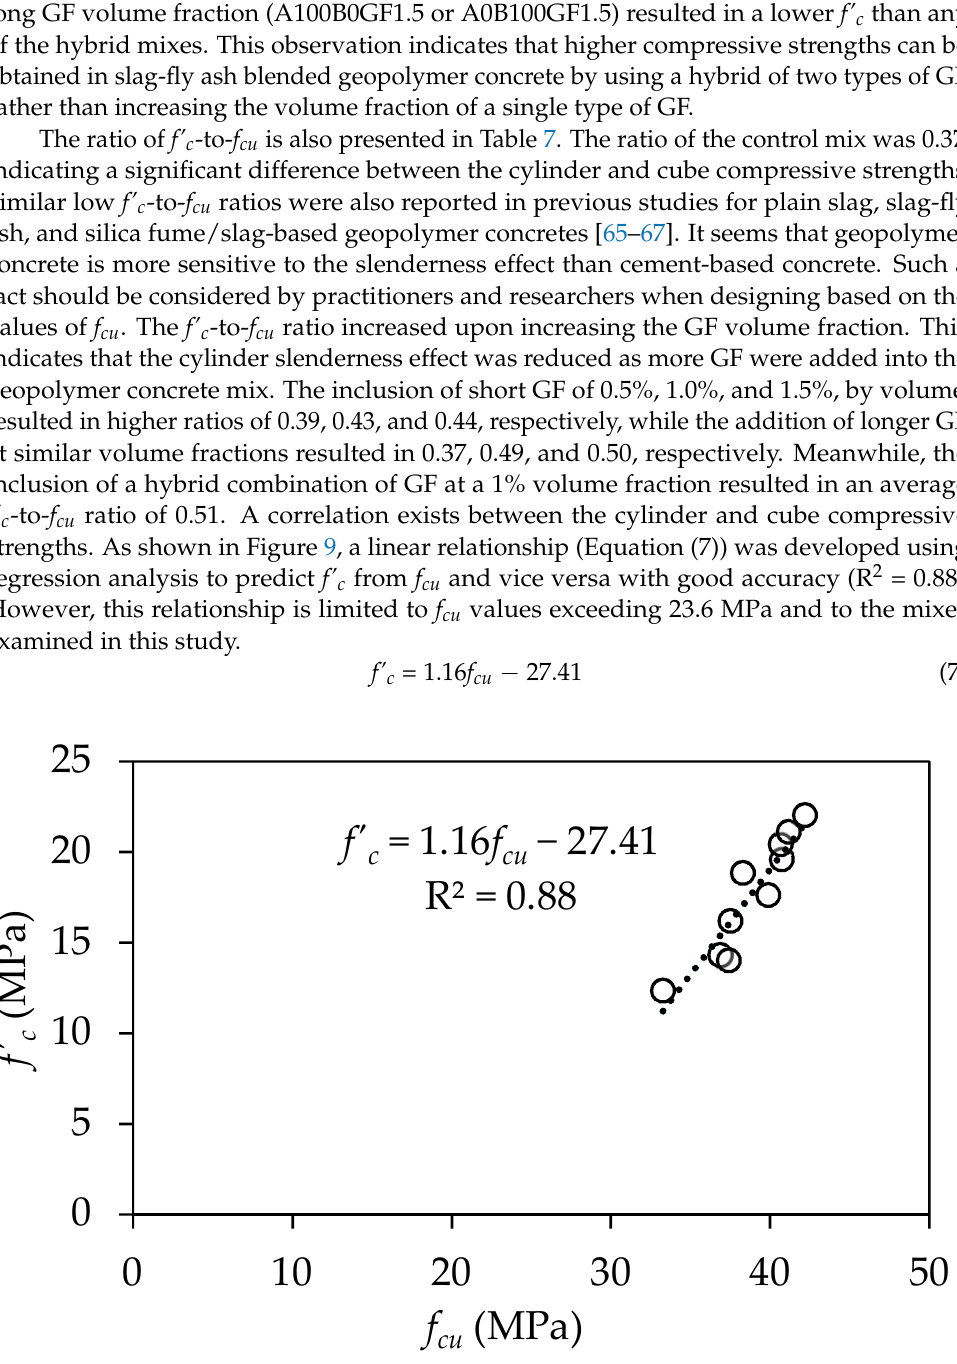
Figure 9. Relationship between the cylinder and cube compressive strengths at 28 days.